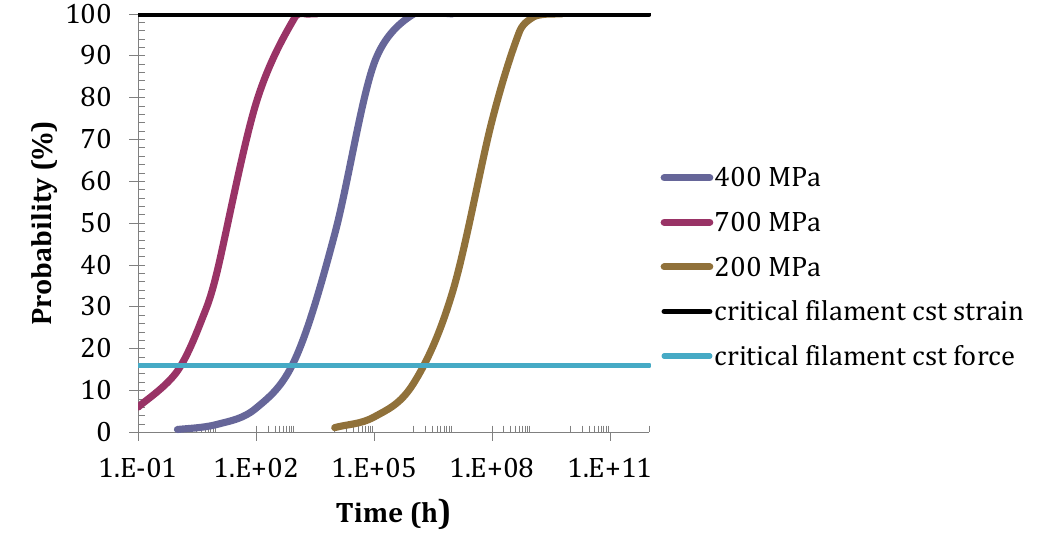
Figure 3. Statistical distributions of E-glass filament lifetimes under various constant stresses (200, 400, 700 MPa) in water, calculated using Equation (8), and the database given in Table 1. The critical filament lifetimes for tows under constant strain ( P = 0.99) and constant force ( P = α t = 0.16) are also shown.